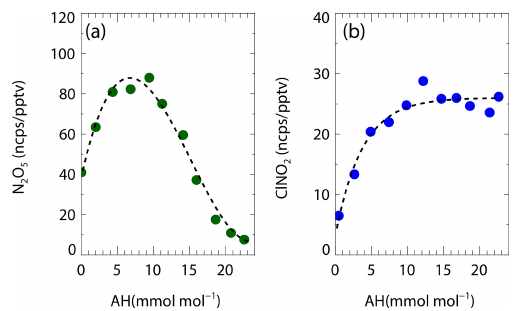
Figure A2. CIMS sensitivities as a function of absolute humidity (AH) for (a) N 2 O 5 and (b) ClNO 2 .